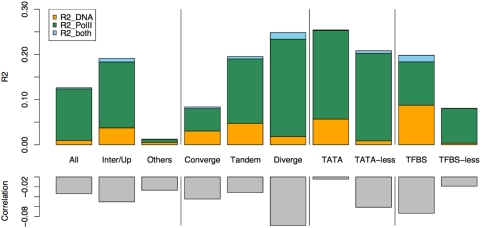
Dissection of the effects of DNA affinity for histones and Pol II for nucleosome depletion.The upper panel shows the total R
2 (percentage of variance) that can be explained by either DNA affinity for histones or transcriptional activity (Pol II binding), which is further divided into three parts: those explained by DNA affinity for histones (R2_DNA), by Pol II binding (R2_PolII), or by both (R2_both). Part of the variance can be explained by both factors due to their weak correlation between each other, as shown in the lower panel.